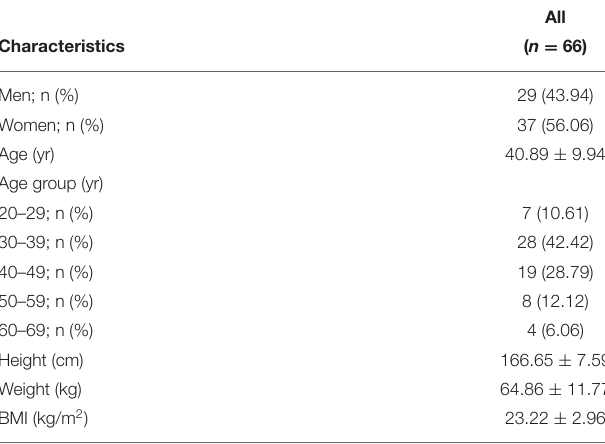
TABLE 2 | General characteristics of participants at baseline.